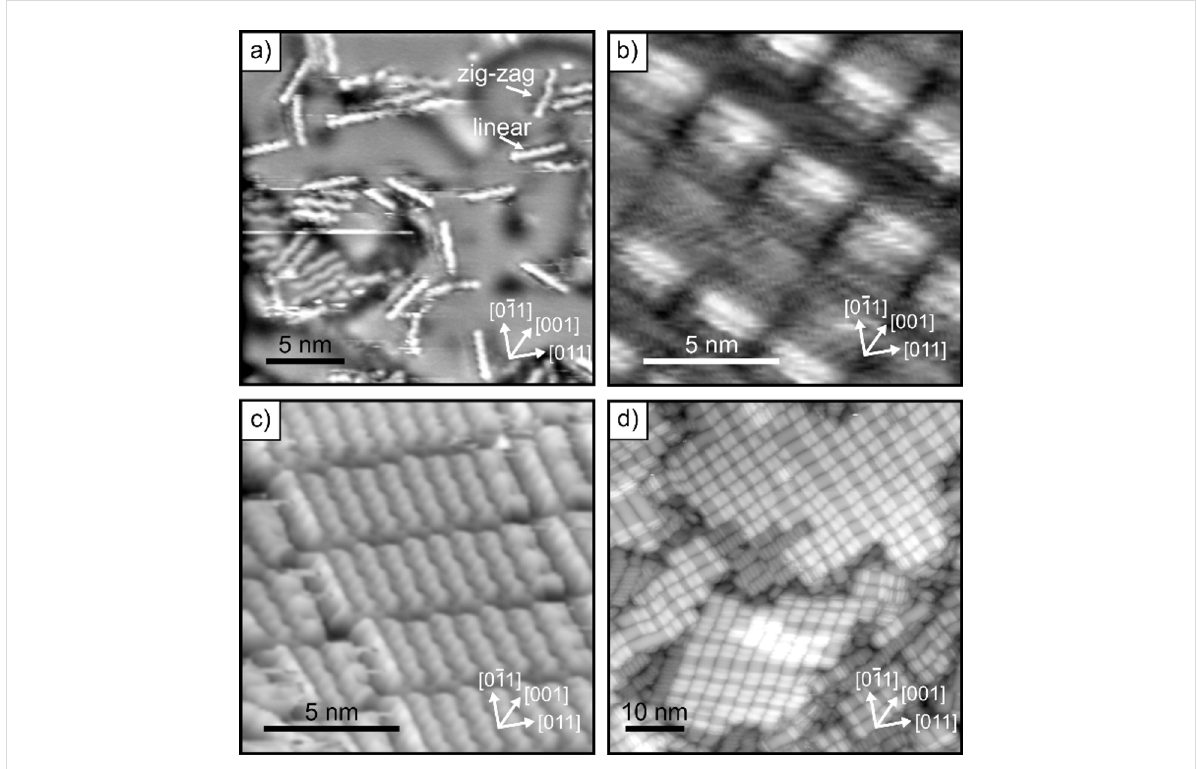
Figure 2: STM images of 6P deposited on (a,b) 2 ML MgO(100)/Ag(100) and (c,d) 3 ML MgO(100)/Ag(100). (a) Individual 6P molecules, T dep,6P = − 193 °C, size: 25 nm × 25 nm, U b = +0.4 V, i t = 25 pA; (b,c) 6P monolayer islands, T dep,6P = 30 °C, size: 13 nm × 13 nm, U b = +1.4 V, i t = 16 pA (b) and U b = − 0.08 V, i t = 140 pA (c). (d) Multilayer 6P islands, T dep,6P = 30 °C, size: 60 nm × 60 nm, U b = +1.7 V, i t = 30 pA. All STM images were re- corded at 80